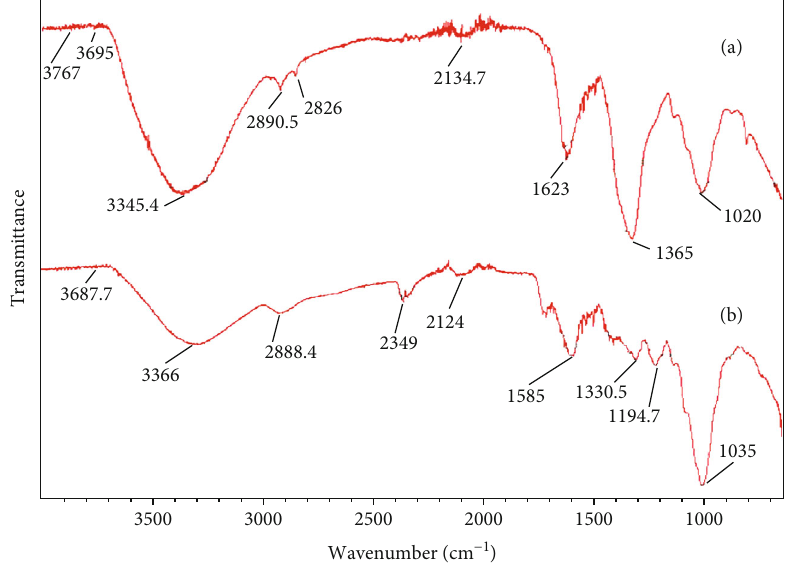
Figure 4: Comparative FT-IR characterization of native adsorbents ((a) PWM and (b)